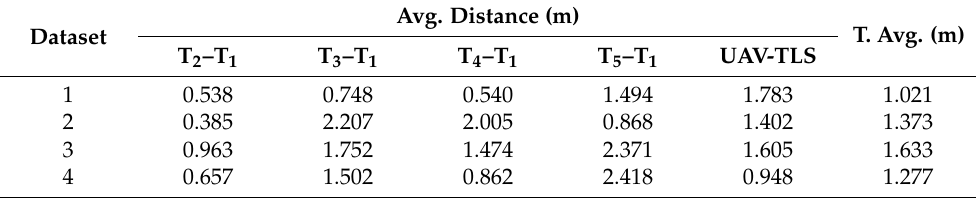
Table 1. Coarse alignment results. ‘Avg. distance’ represents the average distance between the two related point clouds. ‘T. Avg.’ column represents the total average distance of each dataset. ‘T 1 ’ represents the TLS point cloud by scanning in the plot center, ‘T 2 ’, ‘T 3 ’, ‘T 4 ’, and ‘T 5 ’ represent the TLS data by scanning in the four corners of the plot. ‘TLS’ represents all registered TLS point clouds and ‘UAV’ represents UAV